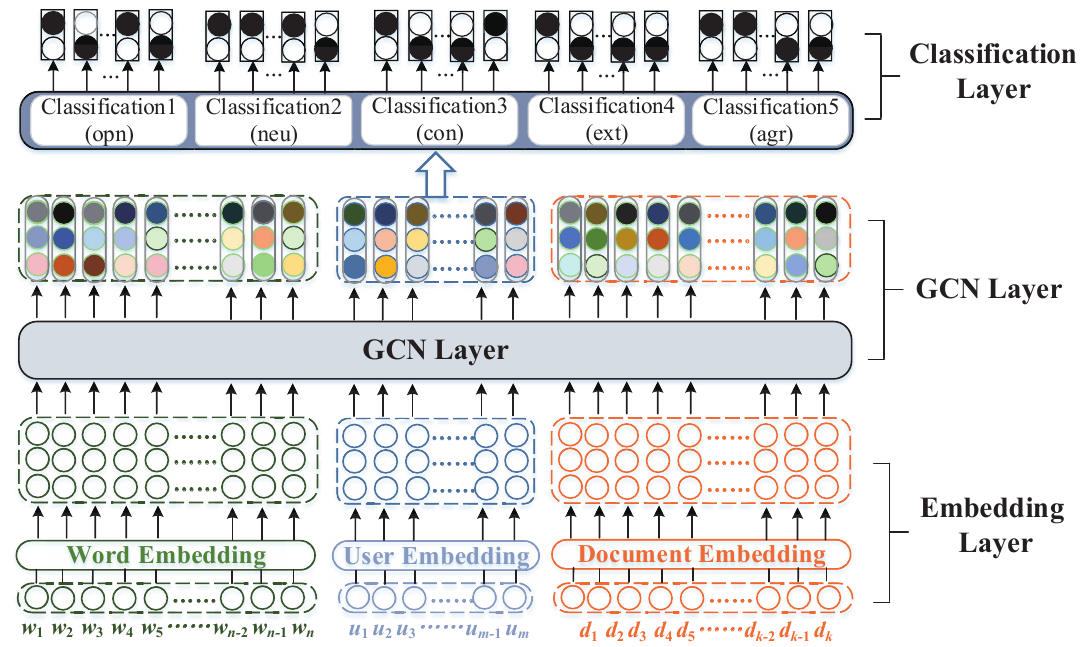
Figure 1. The architecture of personality